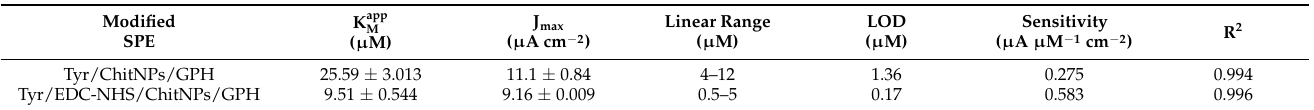
Table 1. Comparison of the kinetic and analytical characteristics of DA biosensors with different electrochemical platforms.